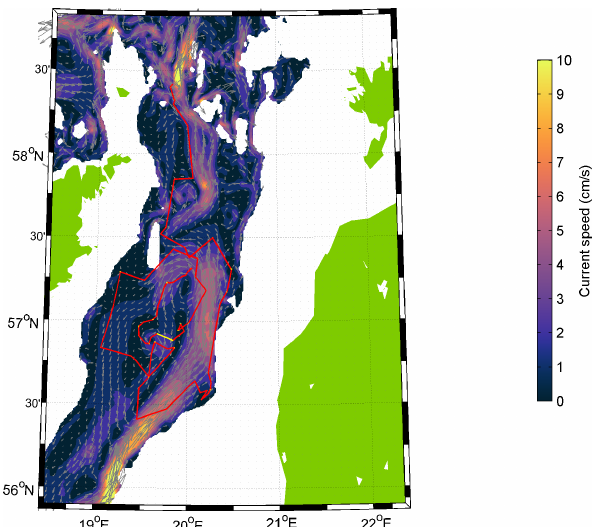
Figure 13. Mean current field between 105 and 135m depth based on simulation data and Argo (WMO number 6902014) float tra- jectory during the period 15 August 2013–15 August 2014 in the deep layer (within its parking depth range of 105–135m, shown in red). Only one longer period occurred when the float drifted on the surface (shown in white). The color scale shows current speed in centimeters per second (cms − 1